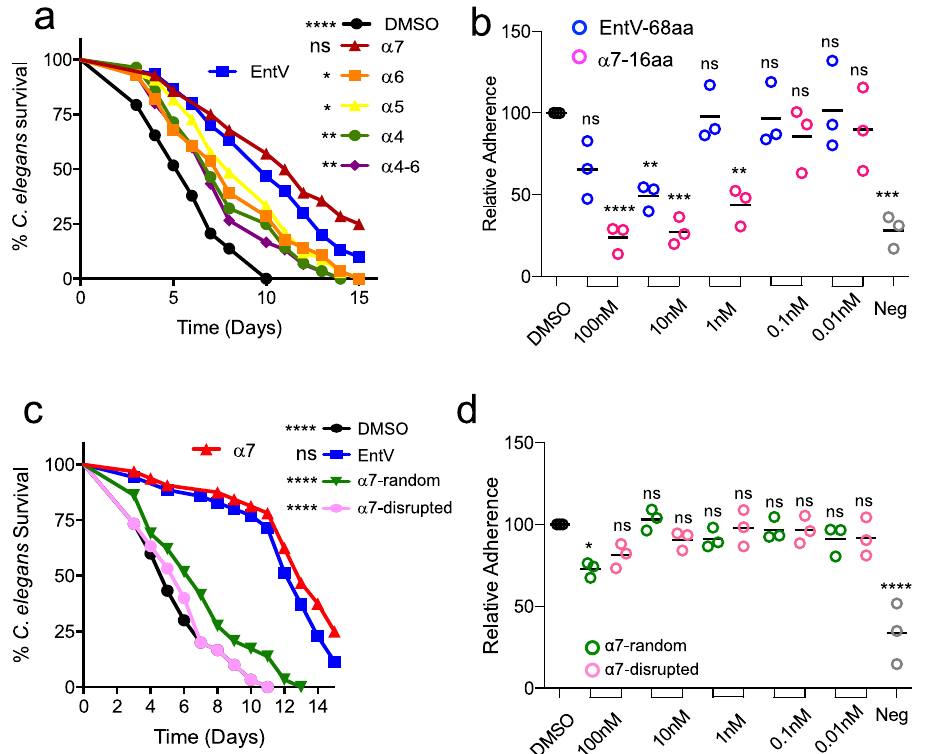
Fig.2|The α 7helixofEntVhasantifungalactivity.a , c showsurvivalovertimeof C.elegans infectedwith C.albicans andexposedto1nMoftheindicatedfragments of EntV based on the structure in Fig. 1a or versions of the α 7 helix, respectively. Random sequence = TNVGALWICGLAVIQAAQLS and disrupted sequence= TNAAAAQQGGIICLLVVWLS. Statistical differences in survival were compared to animals in the exposure condition on the left of each legend by Mantel – Cox log rank analysis. An n of 60 animals was used and one representative trial is shown. Exact p values from top to bottom: a <0.0001, 0.1900, 0.0361, 0.0583, 0.0059, 0.0019. c <0.0001, 0.1666, <0.0001, <0.0001. Median survival and p values of all trials are shown in Supplementary Data 1. b , d show adhesion of C. albicans to